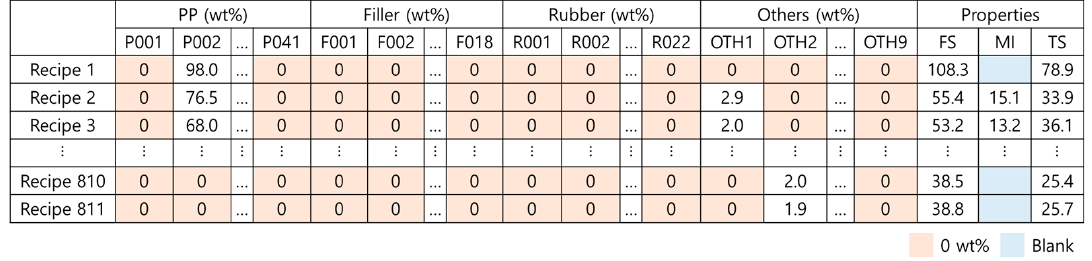
Figure 2. Raw data of PP composite recipes, including 90 types of material and FS, MI, and TS. Table 1. The number of different materials used per PP composite component.